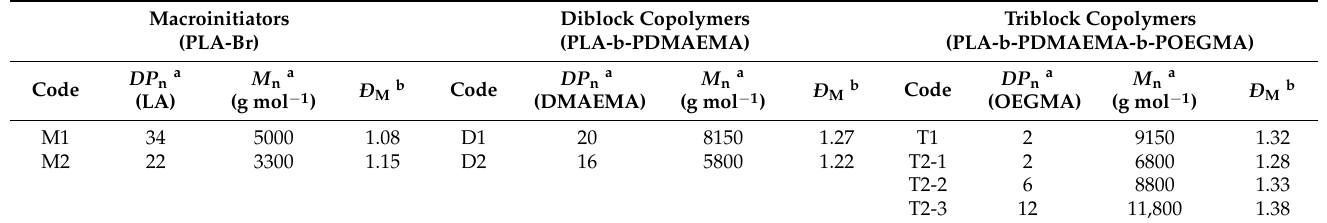
Table 1. Molar mass characteristics of macroinitiators and the amphiphilic diblock and triblock copolymers.